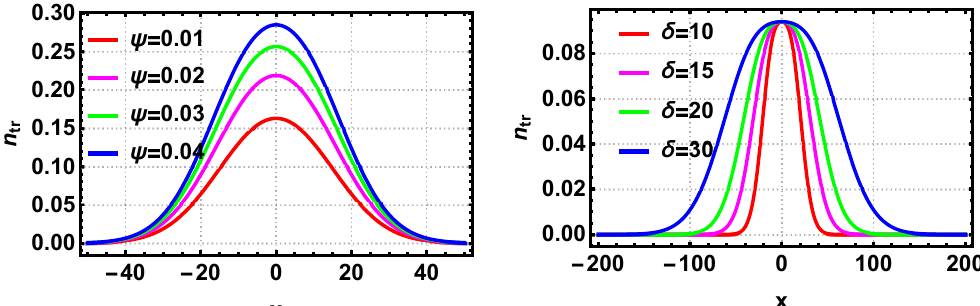
Figure 3. The dependence of trapped ion density for different ψ and δ is shown. The left panel shows the case for different ψ , for fixed T r = 0.5 and δ = 10. The right panel shows the case for different δ keeping the T r = 0.5 and ψ = 0.01